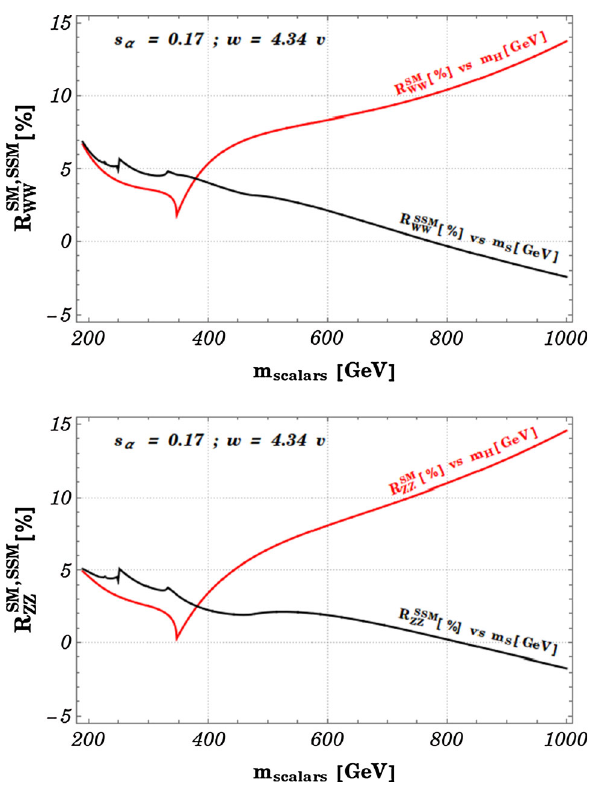
Fig. 4 R SM (red line) and R SSM (black line) as a function of the scalar VV VV mass m scalars .InthecaseoftheSSM,wefixed ( s α = 0 . 17 , w = 4 . 34 v)